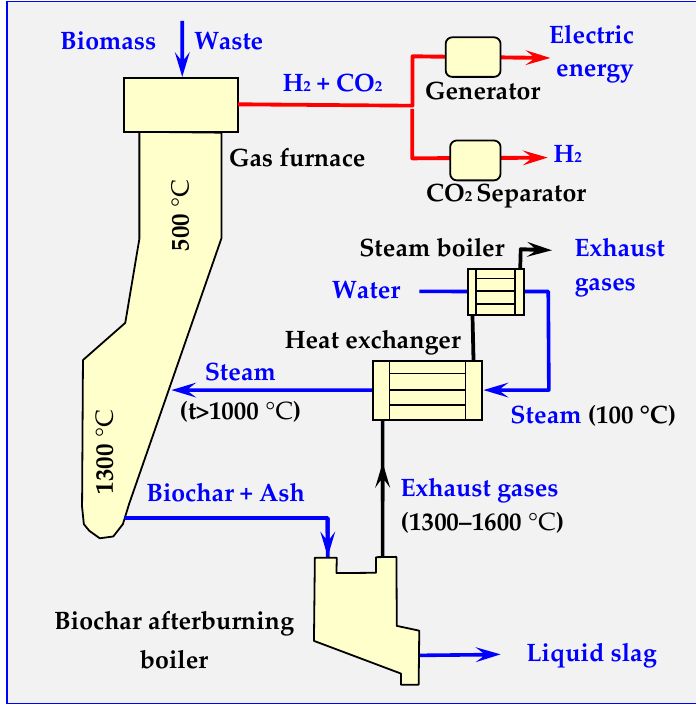
Figure 25. Diagram and view of the pilot HyPR-MEET installation with a capacity of 50 kg/h [17,189]. The Future of SCWG